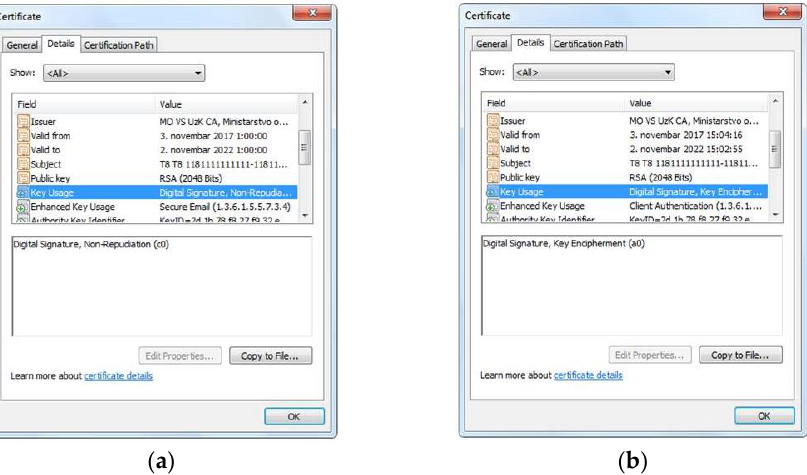
Figure 4. Digital certificates for LiDAR radar. ( a ) Digital certificate for electronic signature; ( b ) Digital certificate for encryption.